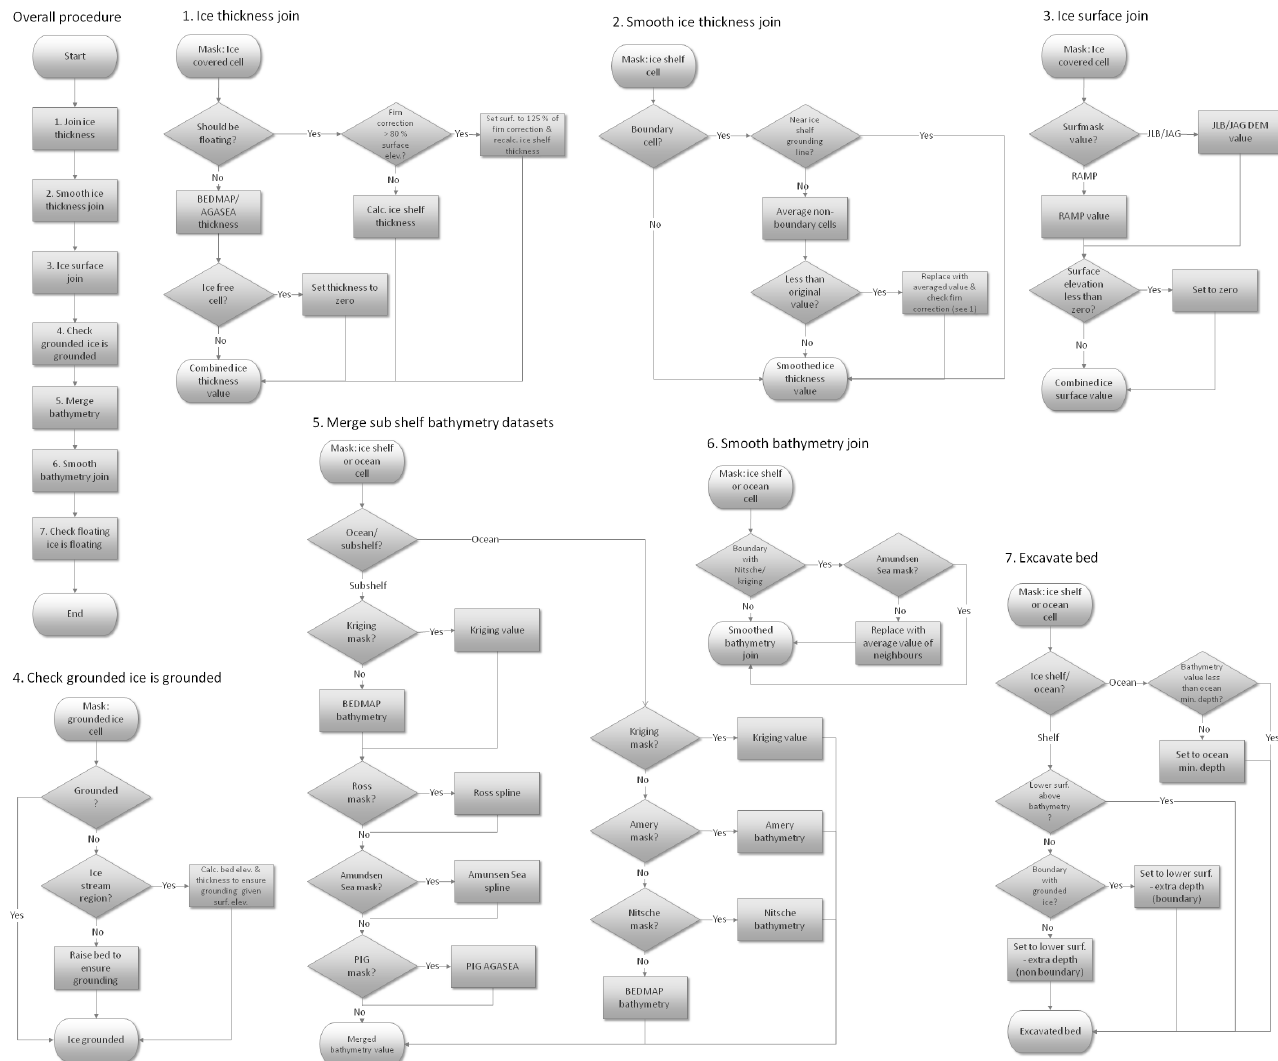
Figure 2. Flow diagram illustrating the processing procedure for the ice sheet configuration datasets.